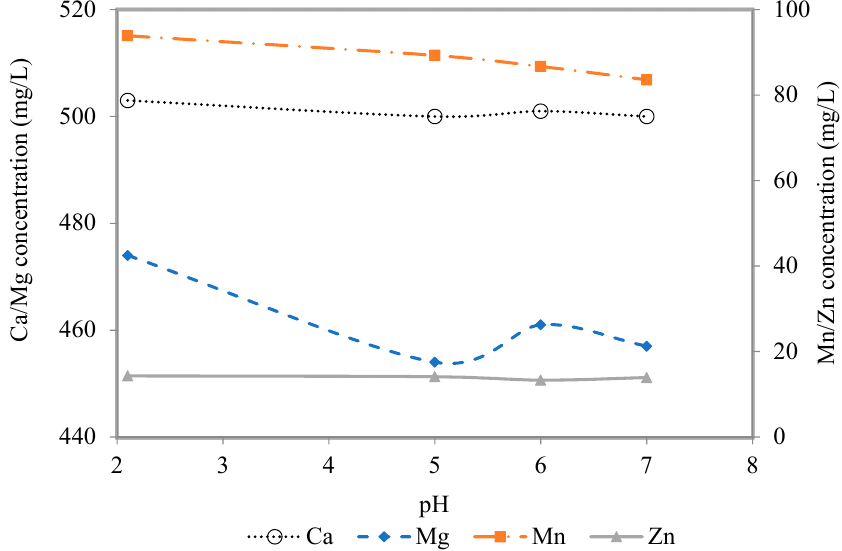
Figure 3. Solubility of the major heavy metals as a function of pH in the raw and treated AMD solutions at 25 °C .